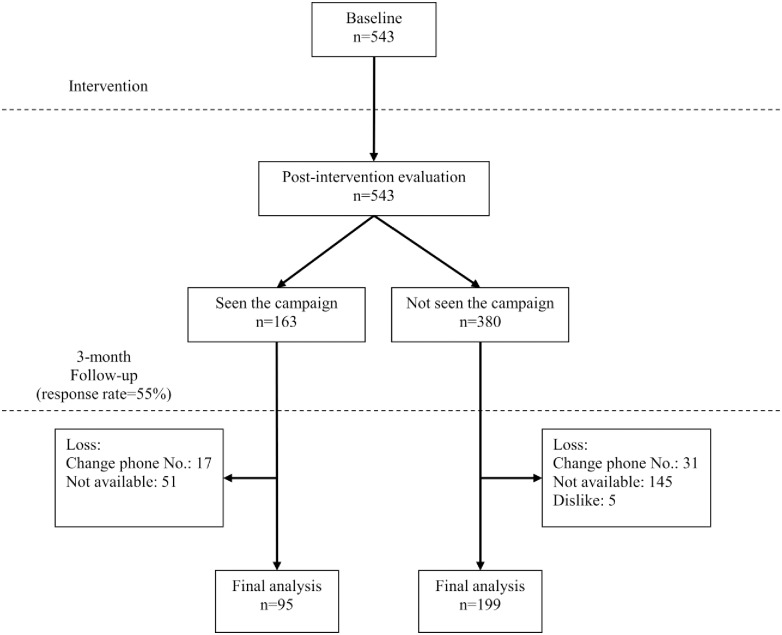
Flow chart of study participants.